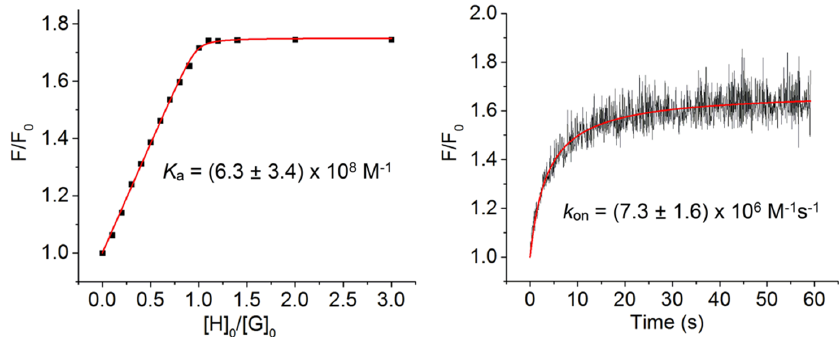
Figure 5. ( left ) Fluorescence (ex: 809 nm, em: 829 nm, slit 5 nm) titration isotherm for incremental addition of M2 to a solution of S3PEG (250 nM) in H 2 O at 25 °C. ( right ) Threading kinetic profile generated by mixing equal molar concentration (50 nM each) of S3PEG and M2 in a stopped flow device (ex: 809 nm, em: 829 nm, slit 5 nm). The red lines are computer fits of experimental data to 1:1 binding model or second order kinetic model, respectively. Table 1. Association constant ( K a ) and rate constant ( k on ) for squaraine threading of M2 in H 2 O at 25 ◦